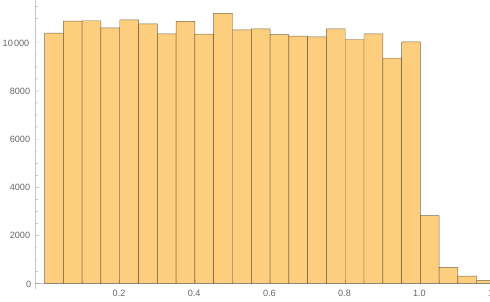
Figure 3 . Distribution of g s for L = 500.